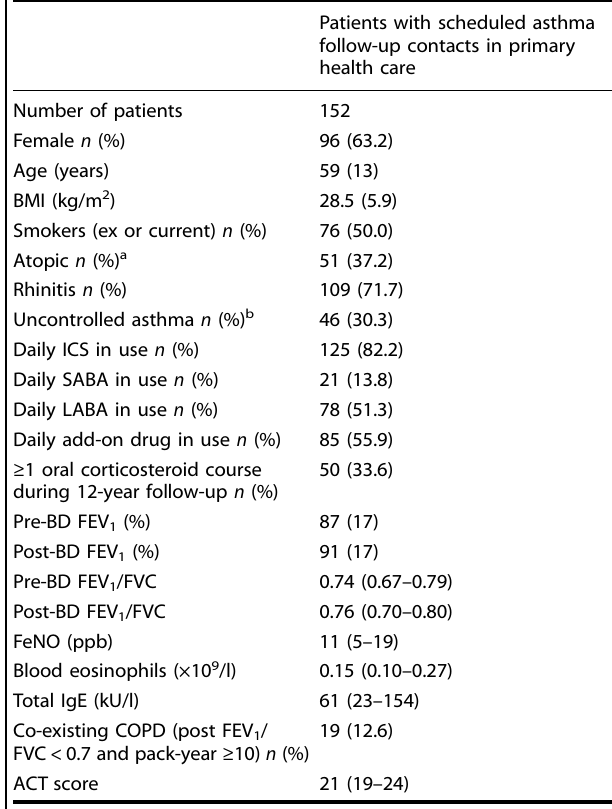
Table 1. Characteristics of the patients ( n = 152) with scheduled follow-up contacts in primary health care at 12-year follow-up visit.